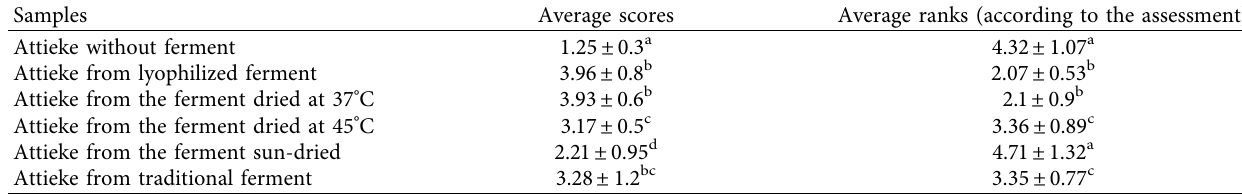
Table 2: Test of ranking by rank of attieke from different ferments.